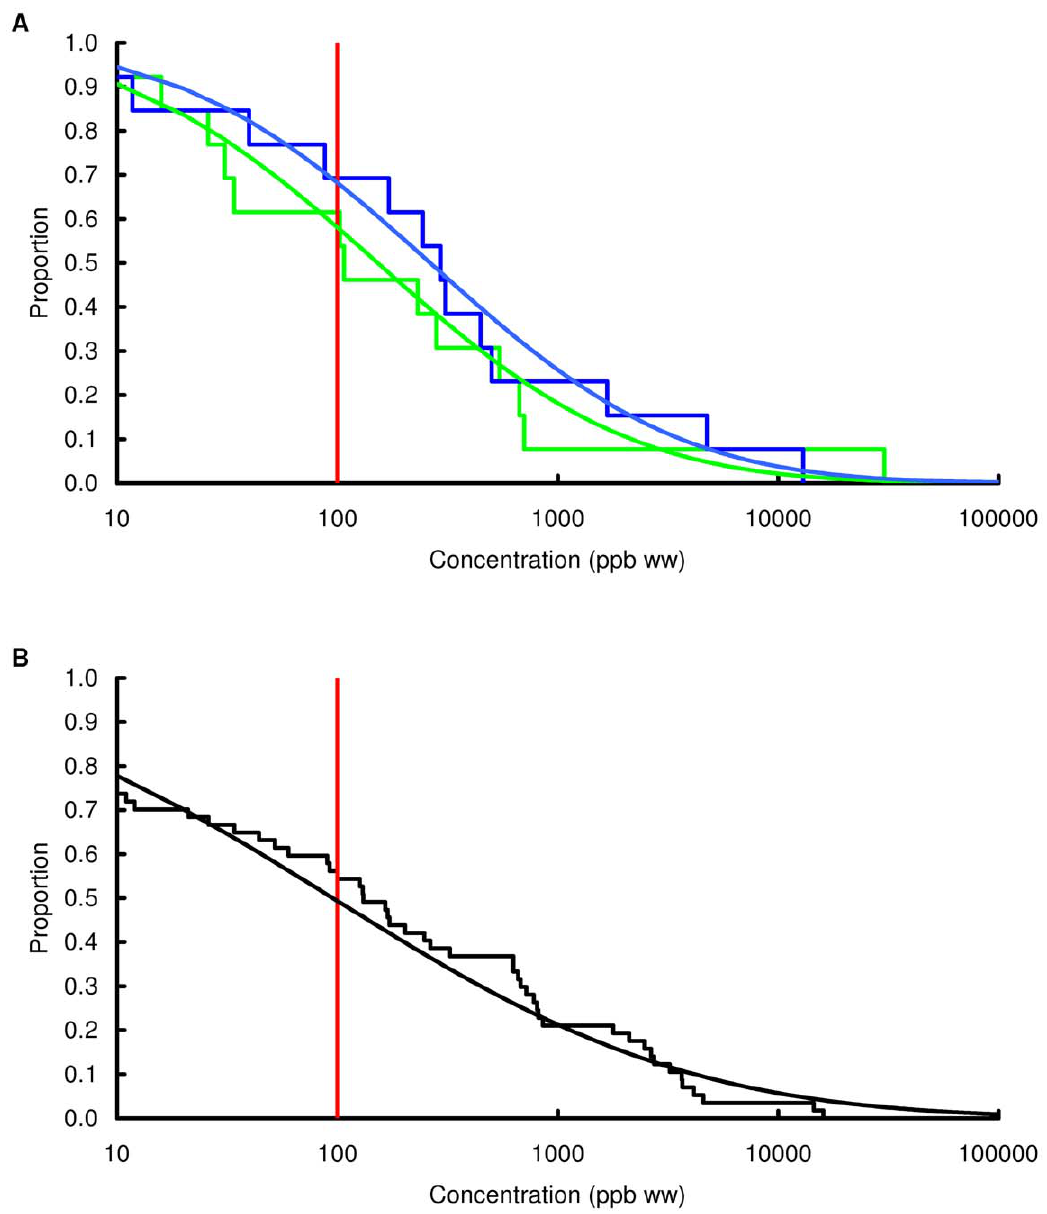
Figure 4. Exceedance distribution of lead concentrations in partridge from the WWT and VMD studies. Observed (stepped line) and fitted (curve) exceedance distribution of lead concentrations (ppb wet weight) in partridge (A) cooked using acidic (green) and non-acidic (blue) methods and (B) fresh uncooked tissue from the VMD statutory surveillance programme. The curves represent lognormal distributions fitted to all the data, including those below the limit of quantification, by a maximum-likelihood method involving left-censoring at the LOD/LOQ. The red vertical line shows the statutory maximum residue level (MRL) for poultry and other non-game meat.